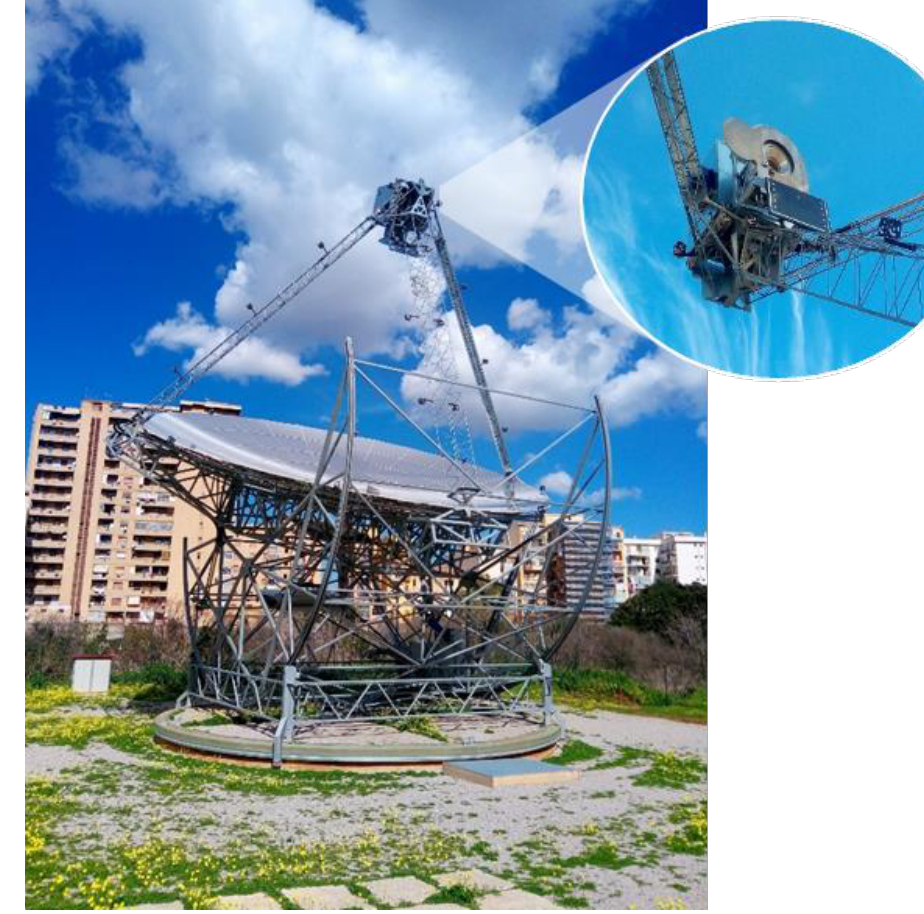
Figure 1. The dish – Stirling concentrator plant that is installed at the University of Palermo. Figure 1. The dish–Stirling concentrator plant that is installed at the University of